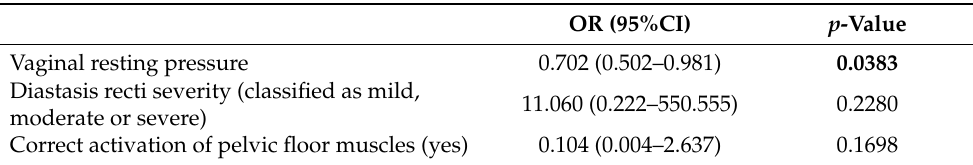
Table 4. Odds ratios (OR) of possible factors associated with pelvic girdle pain using conditional multiple